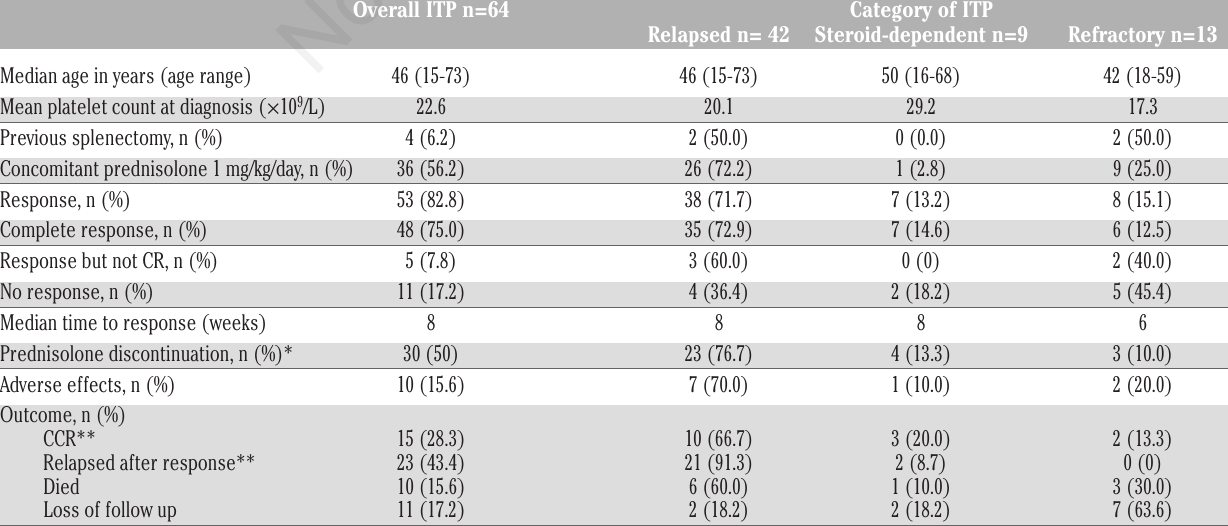
Table 2. Demographic data and treatment response according to category of immune